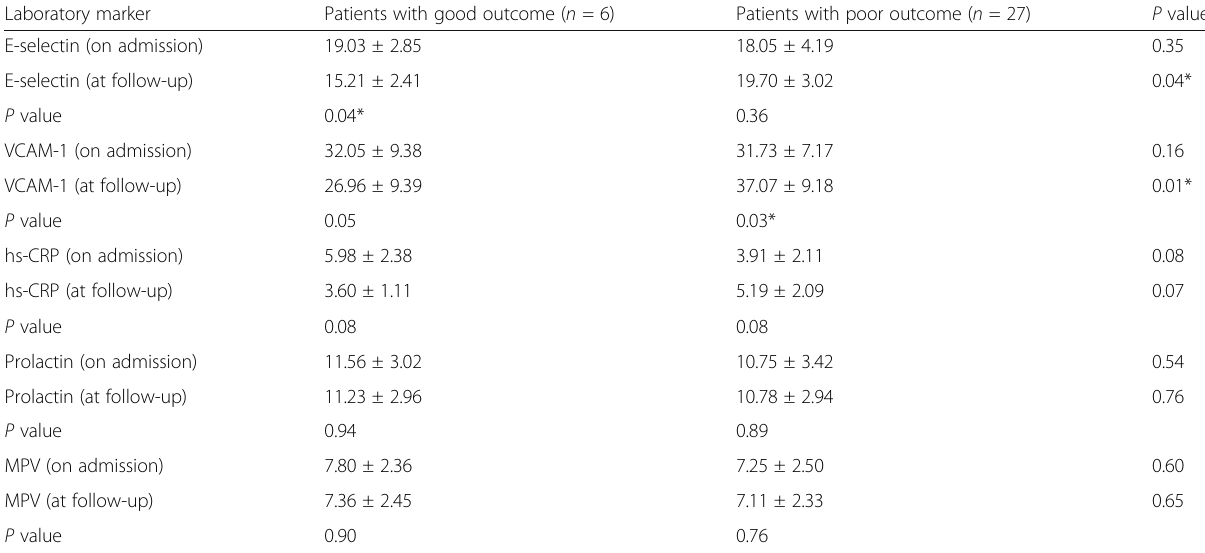
Table 5 Comparison between patients with good outcome and poor outcome regarding the laboratory results on admission and